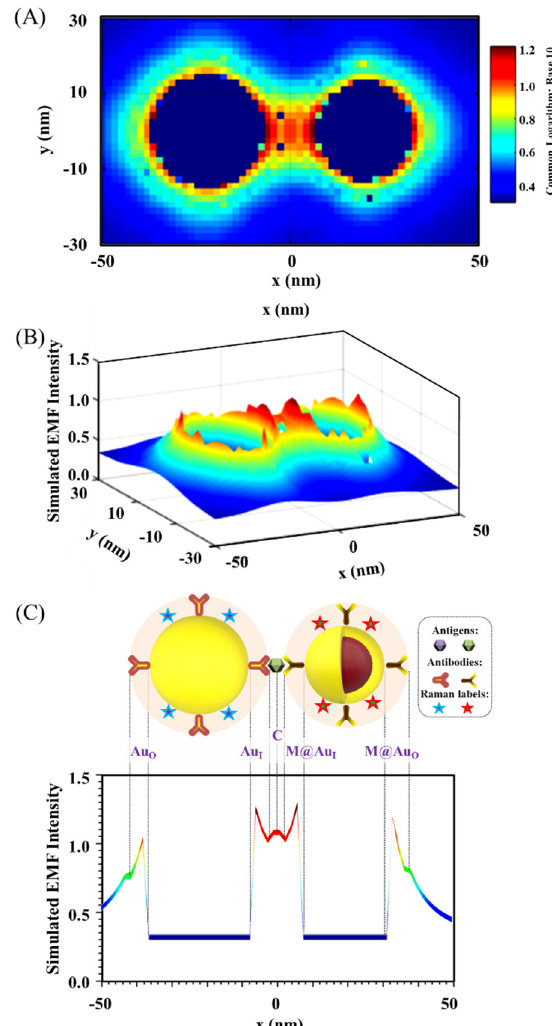
Figure 2. EMF in 2D mapping ( A ), 3D mapping ( B ), and 2D plotting at y = 0 ( C ). The inset in ( C ) is the illustration of the dimer model: Ab1 4.8 nm /Au 30 nm –NSE 4.2 nm –Ab2 4.8 nm /M@Au 26 nm (M@Au NP: 6 nm Fe 3 O 4 core and 10 nm Au shell). Au O , at the outer-edge of Au NP; Au I , at the inner-edge of Au NP; C, at the center of the antigen; M@Au I , at the inner-edge of magnetic core@shell NP (Fe 3 O 4 core-Au shell); M@Au O , at the outer-edge of core@shell NP.